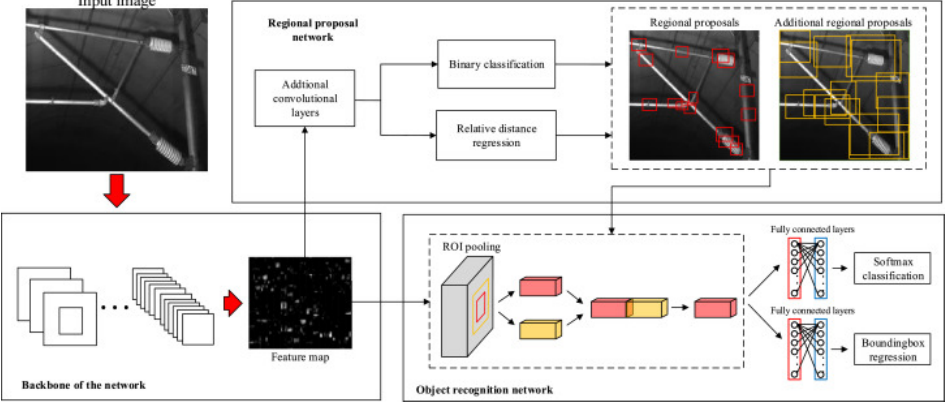
Figure 2. Catenary Inspection Using the Faster R-CNN network. Reproduced with permission from Elsevier